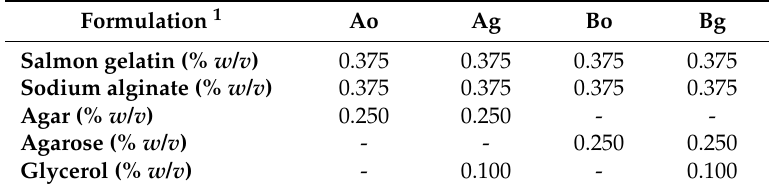
Table 1. Formulation of the polymer solutions used for scaffold preparation. Formulation